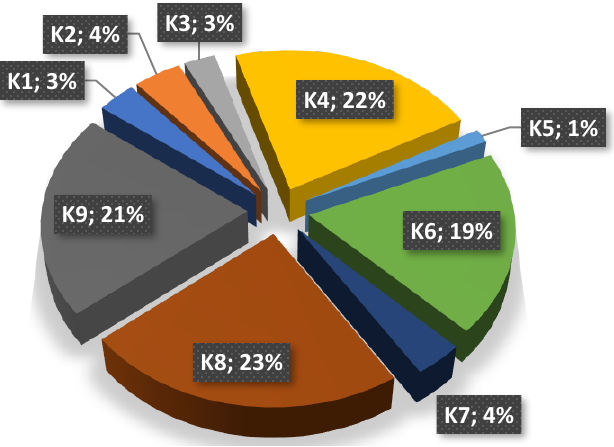
Figure 5. Weighted criteria expressed as percentages, according to Expert 2.